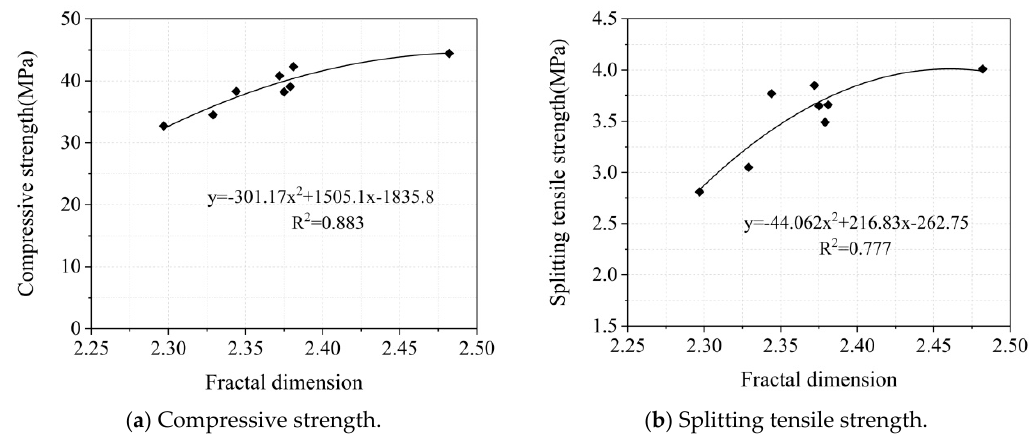
Figure 7. Fitting of strength and fractal dimension.